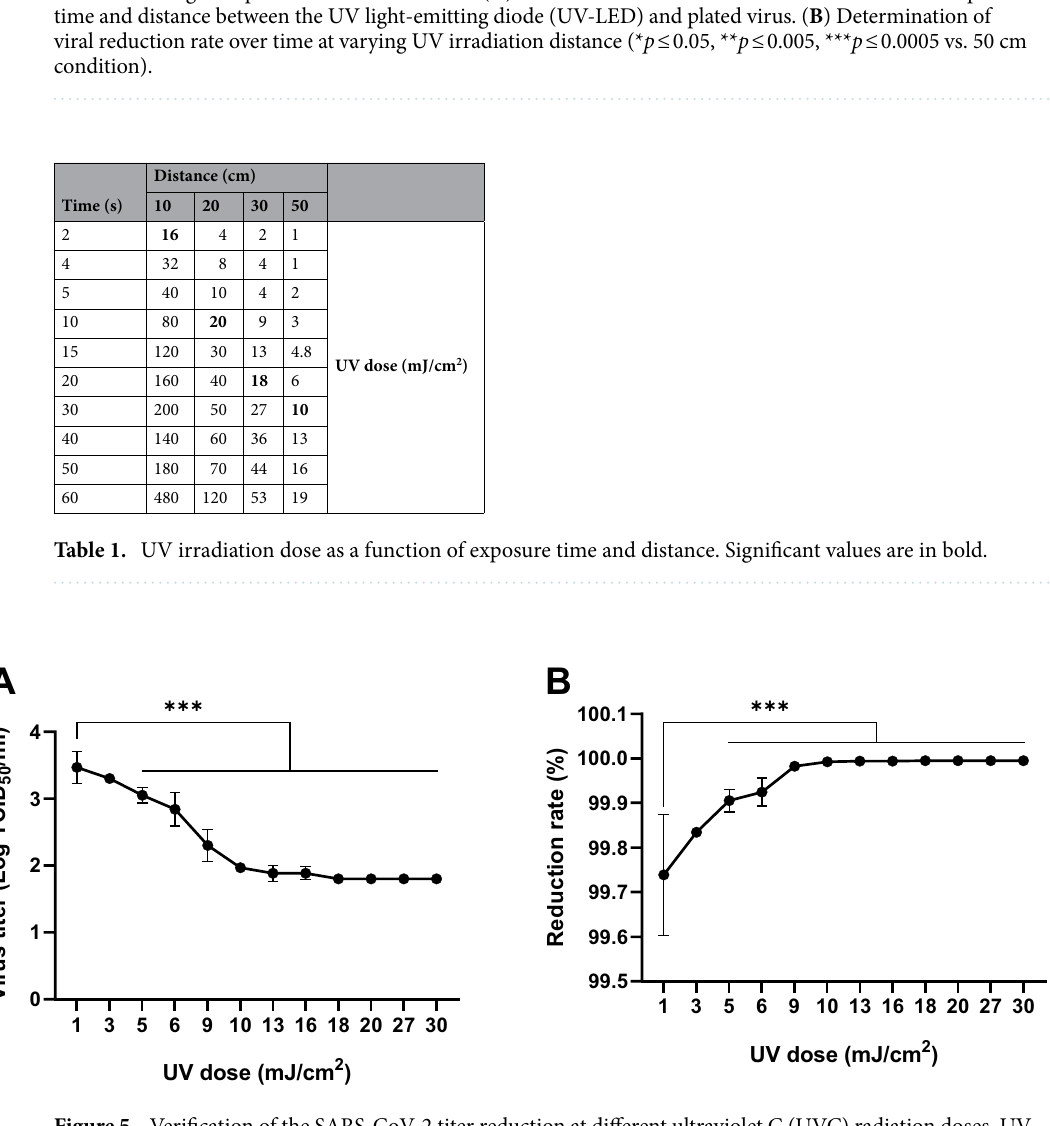
Figure 5. Verification of the SARS-CoV-2 titer reduction at different ultraviolet C (UVC) radiation doses. UV irradiance was deduced based on exposure time and distance between the UV light-emitting diode (UV-LED) and virus. ( A ) The variance of viral titer due to UV irradiation. ( B ) Evaluation of virus reduction rate by UV irradiation. The titer of non-irradiated virus was used as a negative control. *** p ≤